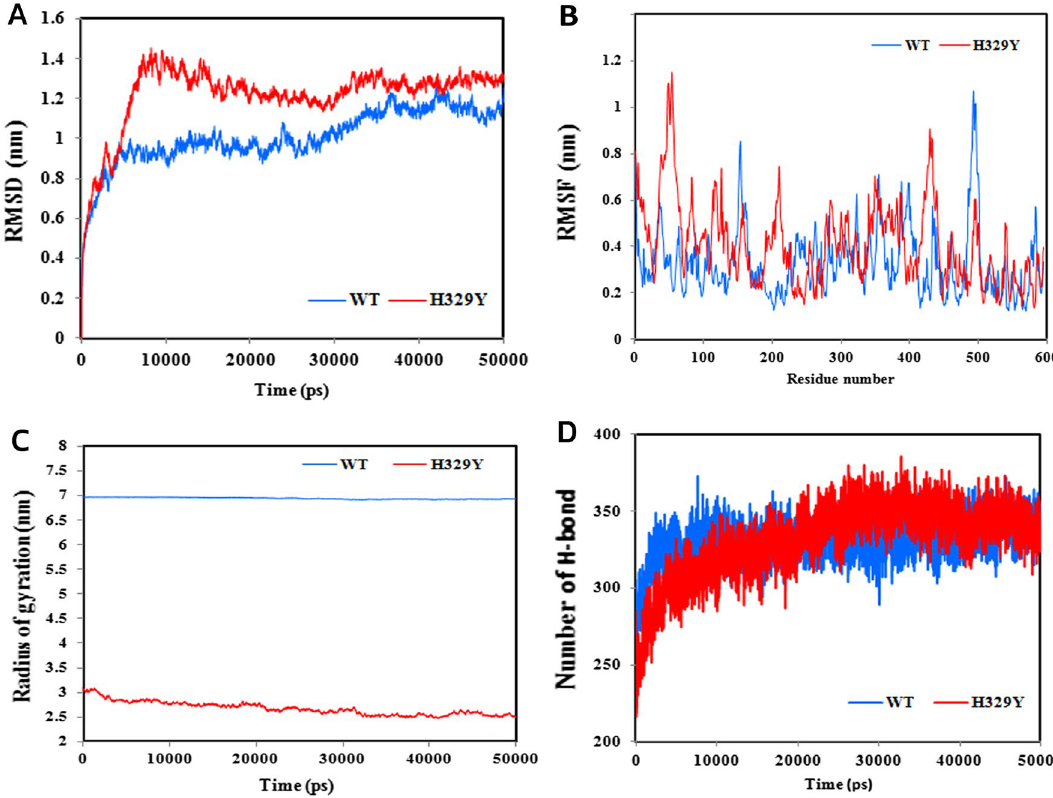
Figure 4. ( A ) Backbone root-mean-square-deviation (RMSD) of the wild-type of GATA6 and the H329Y mutant protein for 50,000 ps molecular dynamics simulation. The wild-type of GATA6 is represented in blue, and mutant H329Y in red. ( B ) RMSF diagram of GATA6 protein backbone atoms and mutant H329Y. The root- mean-square fluctuation for each residue of GATA6 is shown. ( C ) Radius of gyration of GATA6 protein and the H329Y mutant. The Radius of gyration of Cα atoms of the wild-type of GATA6 and the H329Y mutant during the MD trajectory is shown. ( D ) Total number of intramolecular hydrogen bonds for GATA6 protein and the H329Y